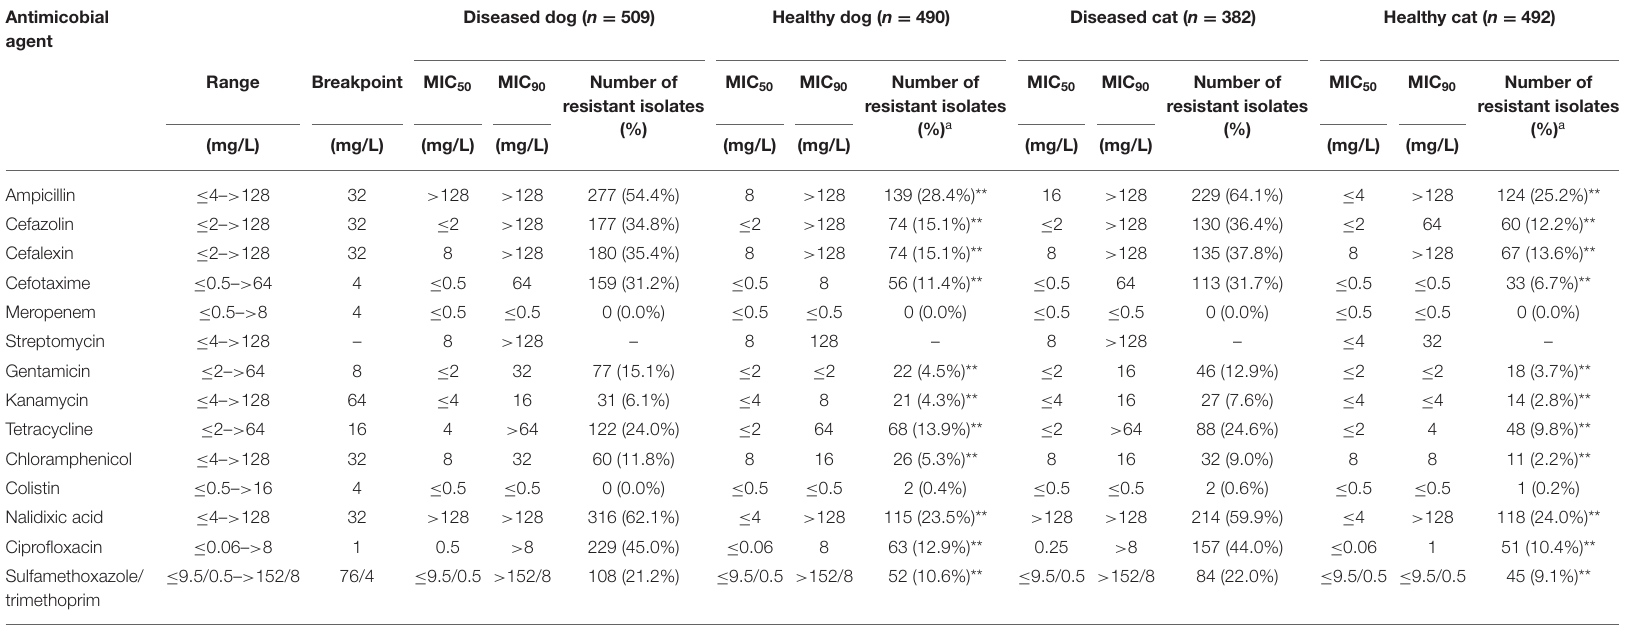
TABLE 1 | MIC for E. coli isolated from diseased and healthy dogs and cats in Japan. Antimicobial